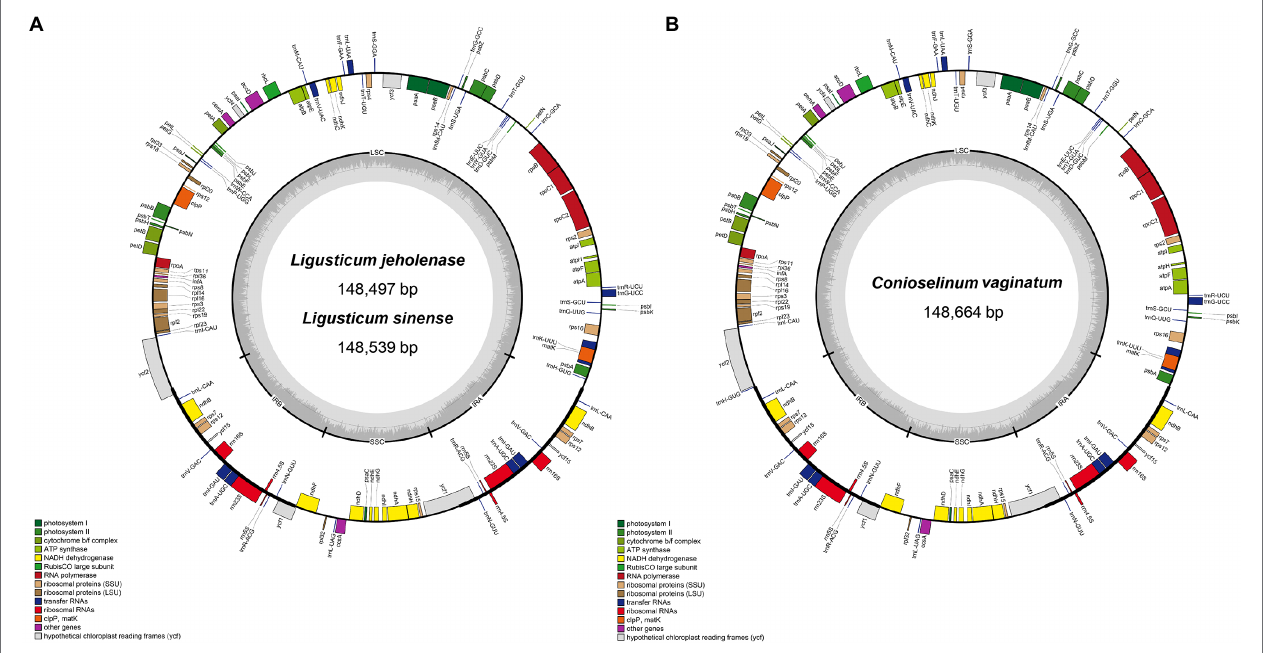
FIGURE 2 | Chloroplast genome maps of (A) Ligusticum sinense and Ligusticum jeholense . (B) Conioselinum vaginatum . Genes drawn inside the circle are transcribed clockwise, and those outside the circle are transcribed counterclockwise. Dark grey shading in the inner circle represents the GC content.